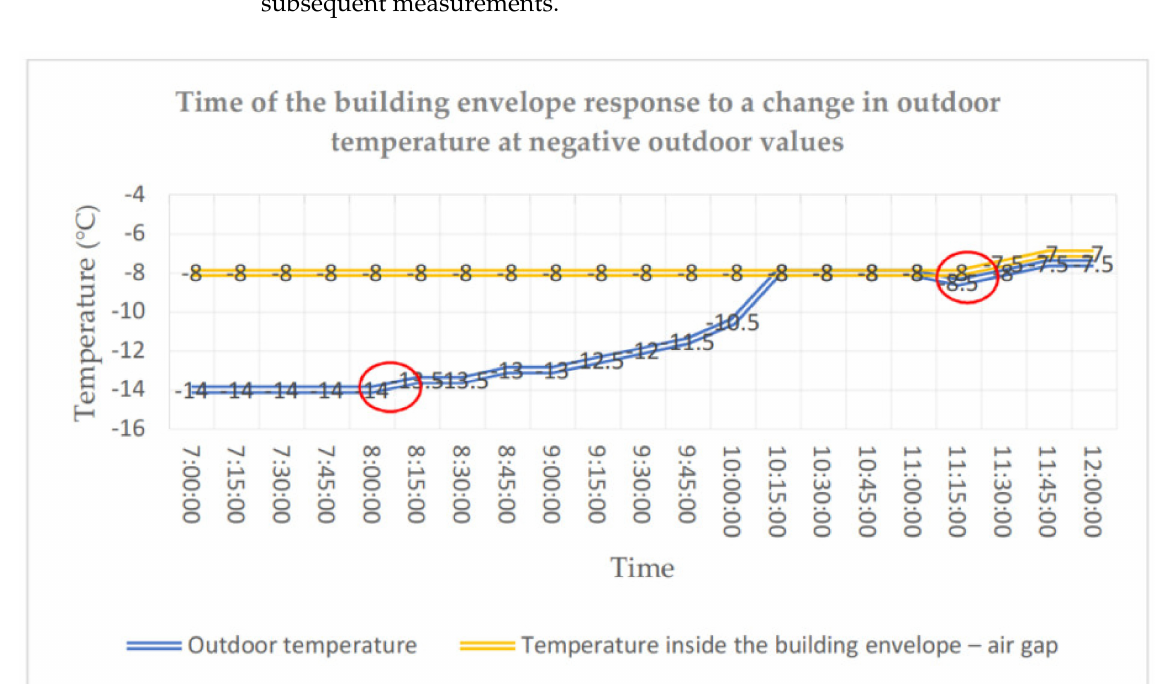
Figure 11. Time of the building envelope response to a change in outdoor temperature at negative outdoor values.